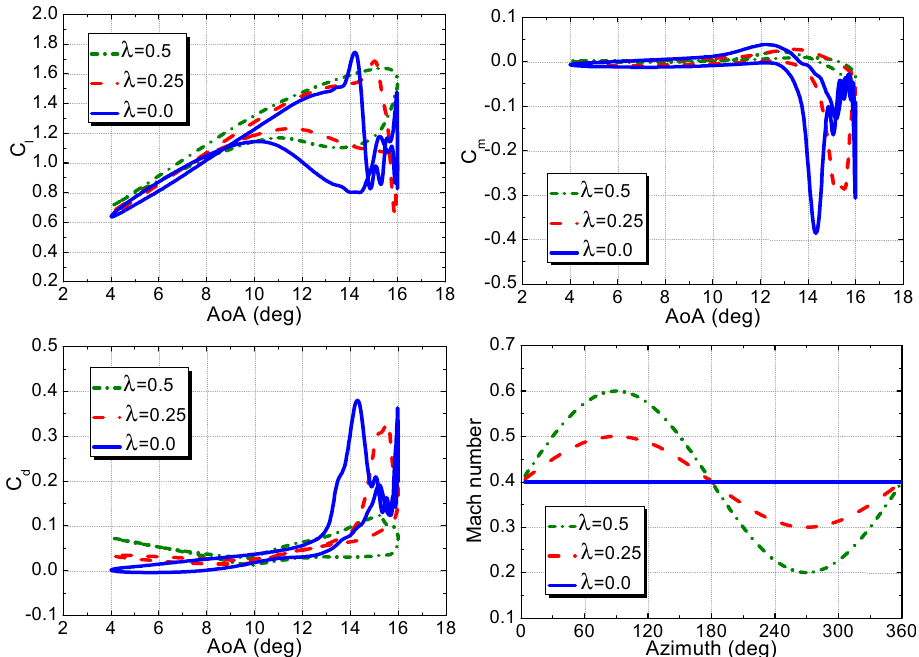
ff erent oscillating velocities (k = 0.05,